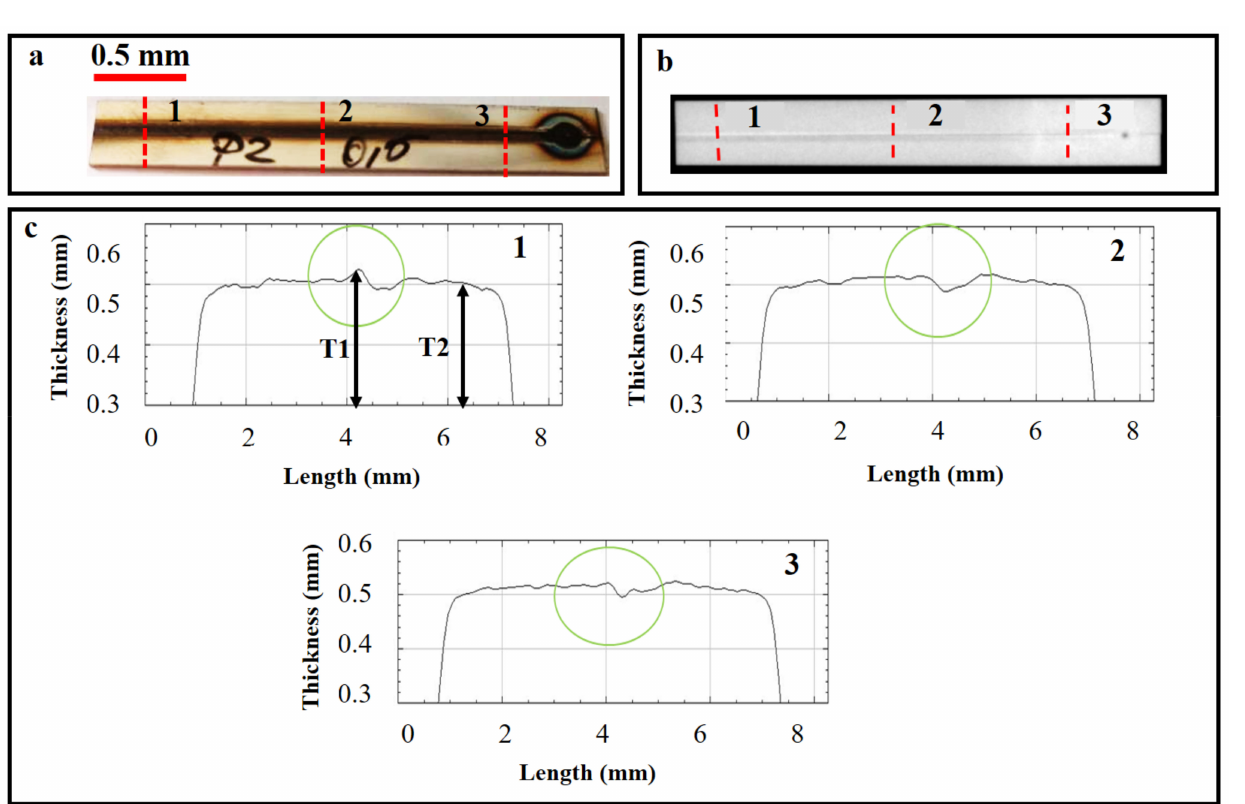
Figure 14. P2 sample ( a ) laser weld by the LMD, ( b ) X-ray analysis of weld using mini-focus X-ray equipment, and ( c ) graphical results of various scans at different positions (1, 2, and